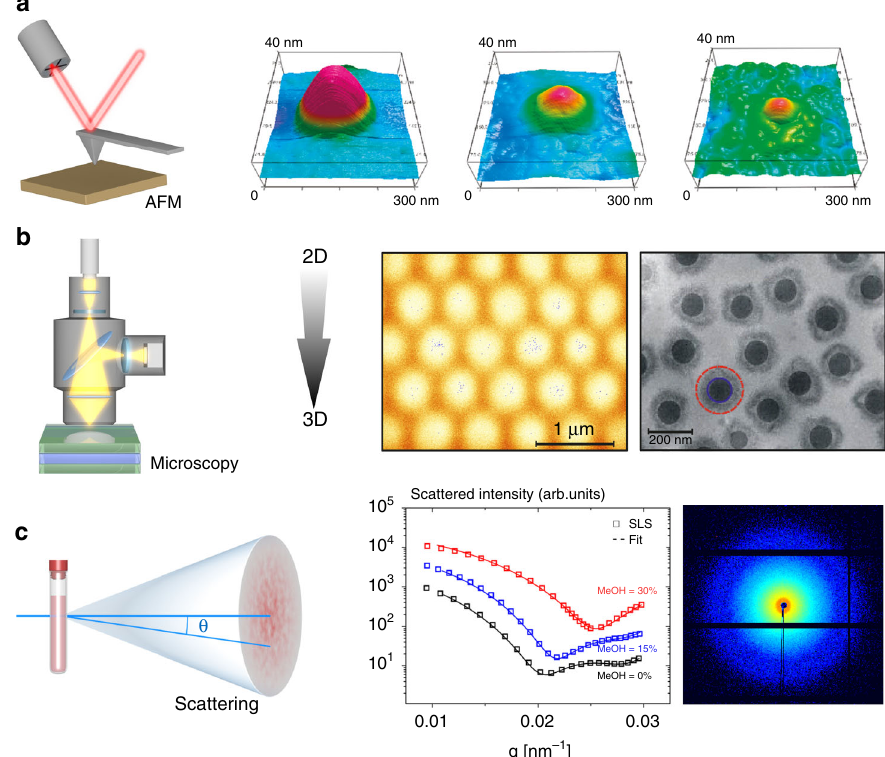
Fig. 2 Conventional experimental techniques employed to characterize microgels and microgel assemblies. a Atomic force microscopy (AFM) is used to measure the shape and swelling of microgels adsorbed at a surface or interface 66,68,69 . Upon drying, the microgels fl atten and acquire a lens-like shape. The AFM images on the right, adapted with permission from ref. 67 (Copyright American Chemical Society, 2010), show the erosion of a biodegradable microgel attached to a hydrophilic glass substrate after 0, 24, and 434 h under ambient, dry conditions. b Microscopy: microgels have been studied